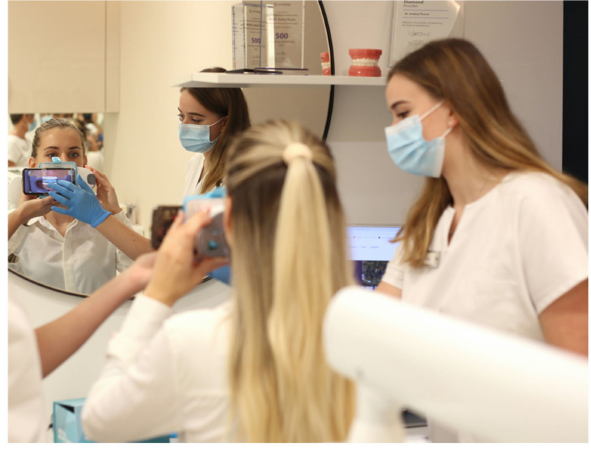
Figure 4. The nurse teaches the patient how to scan properly with the Dental Monitoring ® (DM) (Dental Monitoring Co., Paris, France) scan box. Demonstration